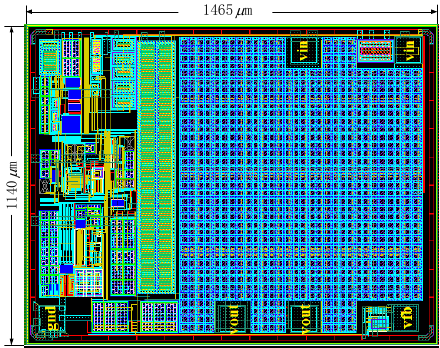
Figure 10. Layout of the proposed regulator with pads.